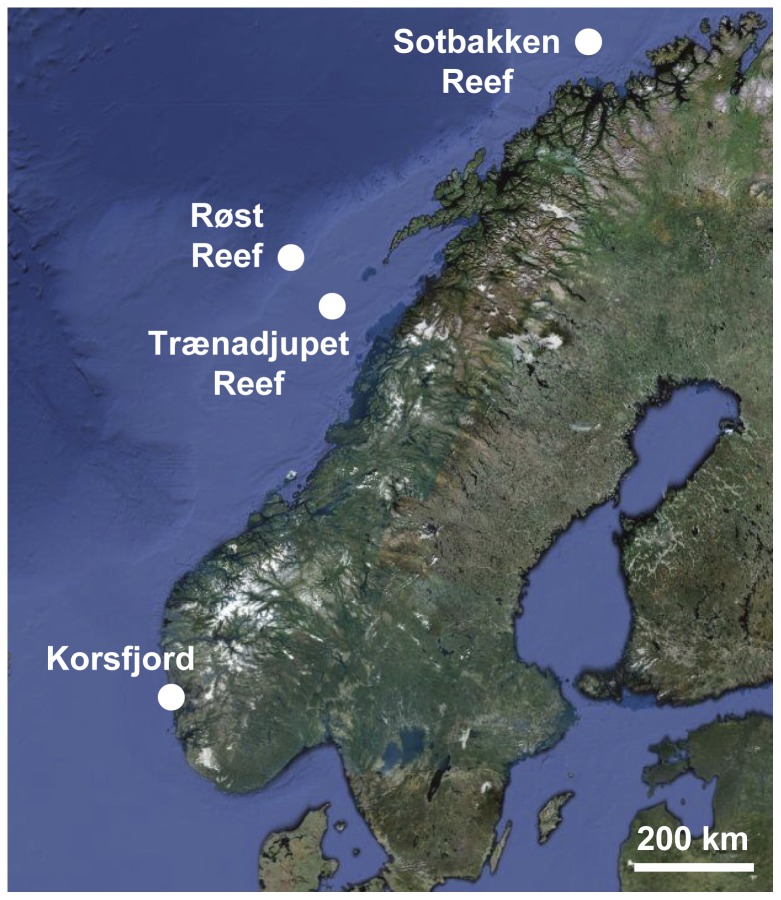
Study sites.Sponges and sediments were sampled at three cold-water coral reef sites off Northern Norway at a water depth of 290–430 m. Additional samples were collected in the Korsfjord on the West coast of Norway at a similar depth range.